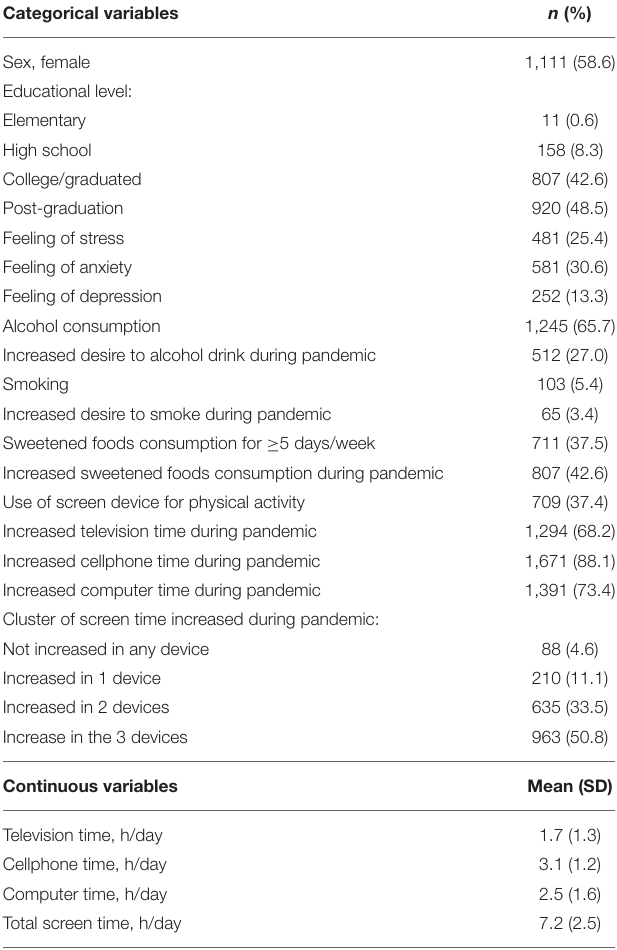
TABLE 1 | Characterization of sample ( n =